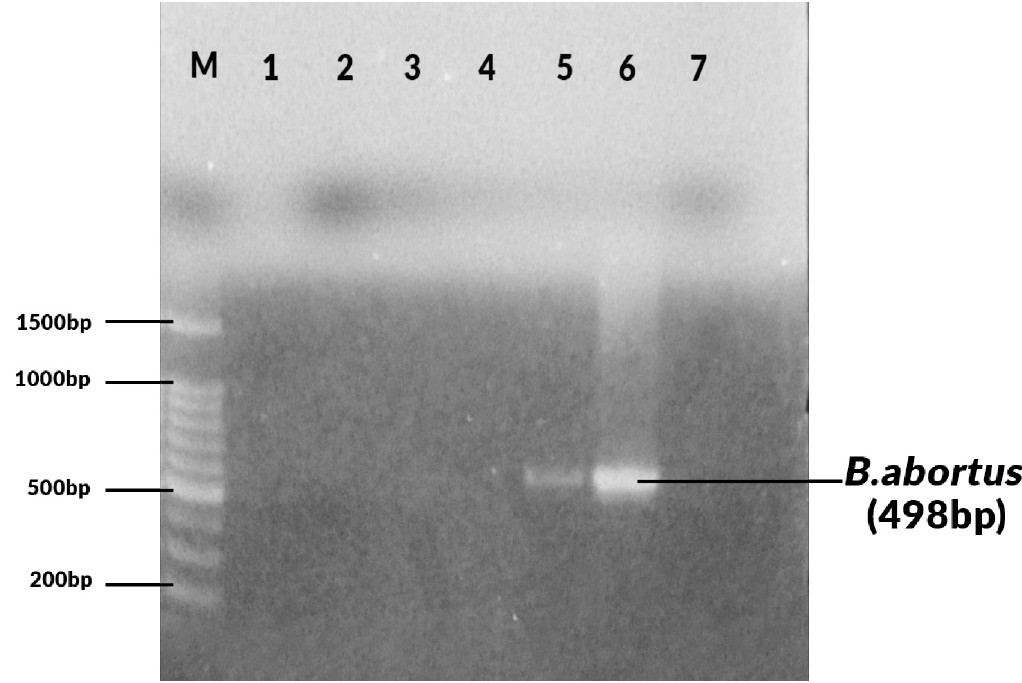
Fig 1. Agarose gel electrophoresis showing 100bp molecular marker (M), negative samples 1, 2, 3, 4, positive samples 5, positive control 6 (S19 B . abortus ) and negative control 7 (double distilled water).